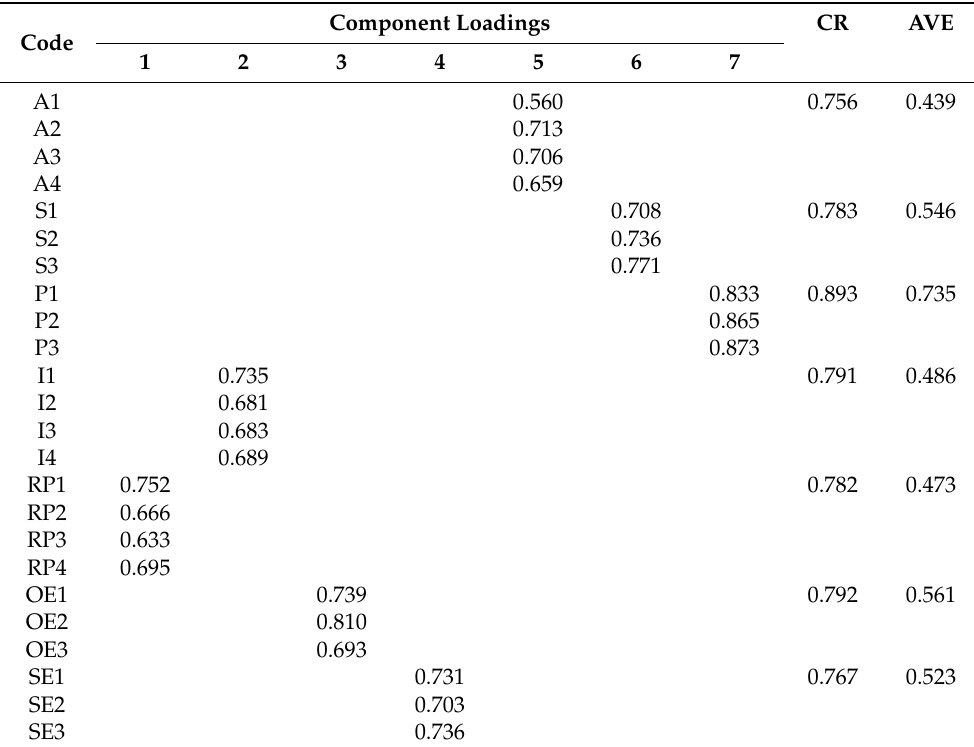
Table 3. Component loading of related